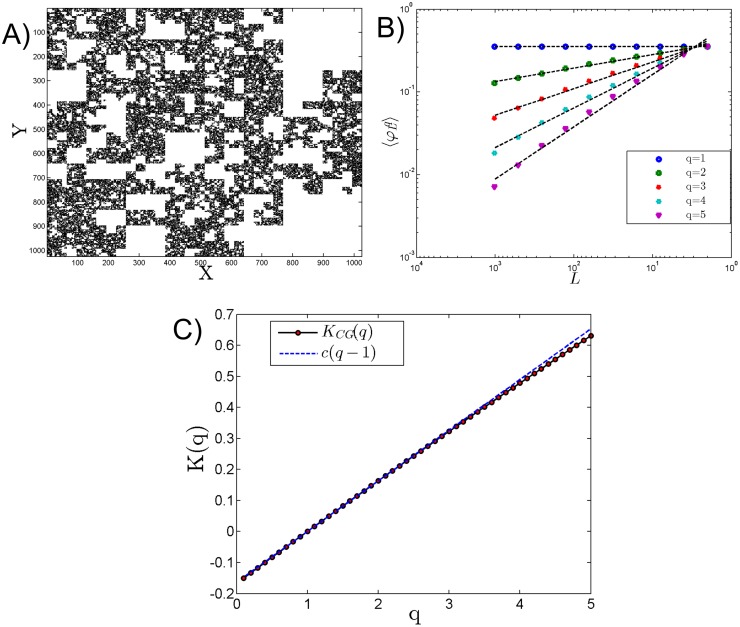
A) simulation of a 2D β model with n = 210 and β = 0.9 (ϵ is displayed), B) coarse grained moments for q = 1 to 5 and C) moment scaling function K(q), where the experimental estimation is shown in dots compared to the theoretical prediction as a dotted line, with c = 0.15.